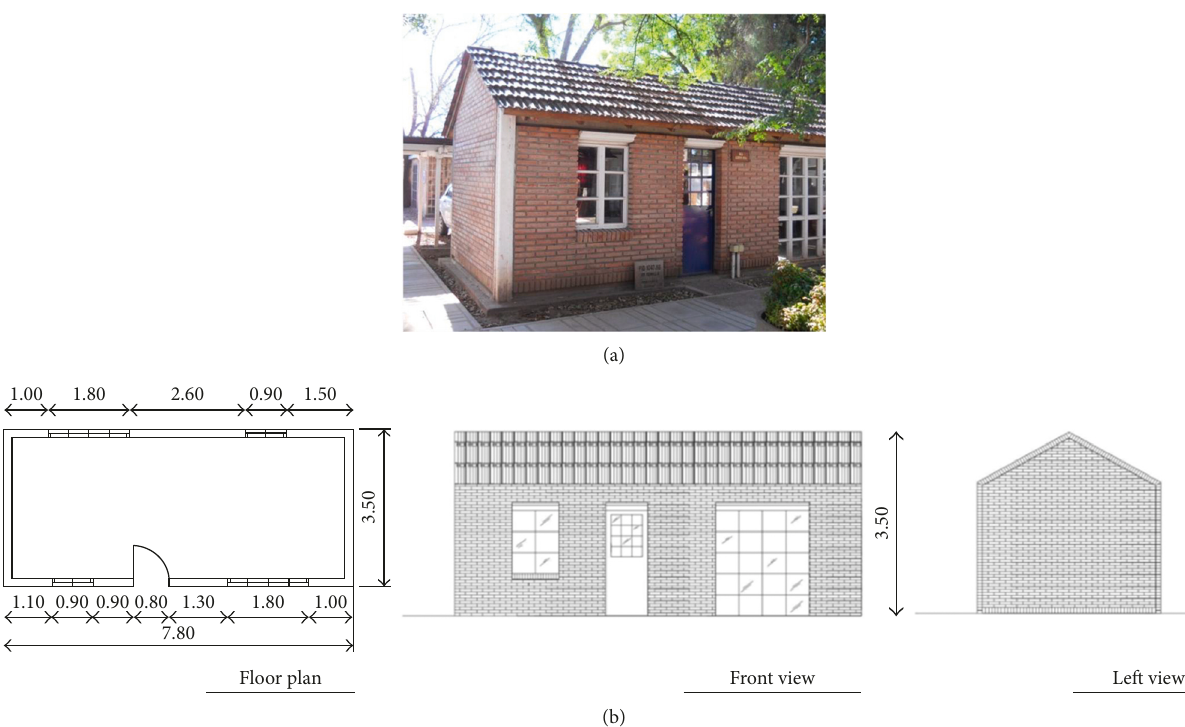
Figure 3: Picture of the prototype used to carry out this study (a). Plant and views of this prototype